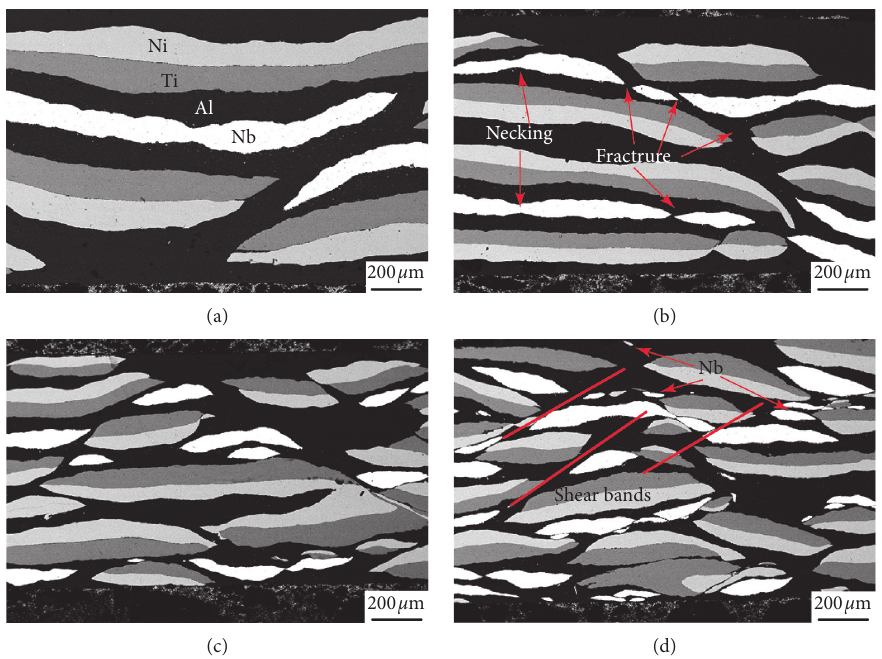
Figure 2: SEM micrographs on the RD-ND plane of the Al-Nb/Ti/Ni composites: (a) 1st pass, (b) 2nd pass, (c) 3rd pass, and (d) 4th pass.